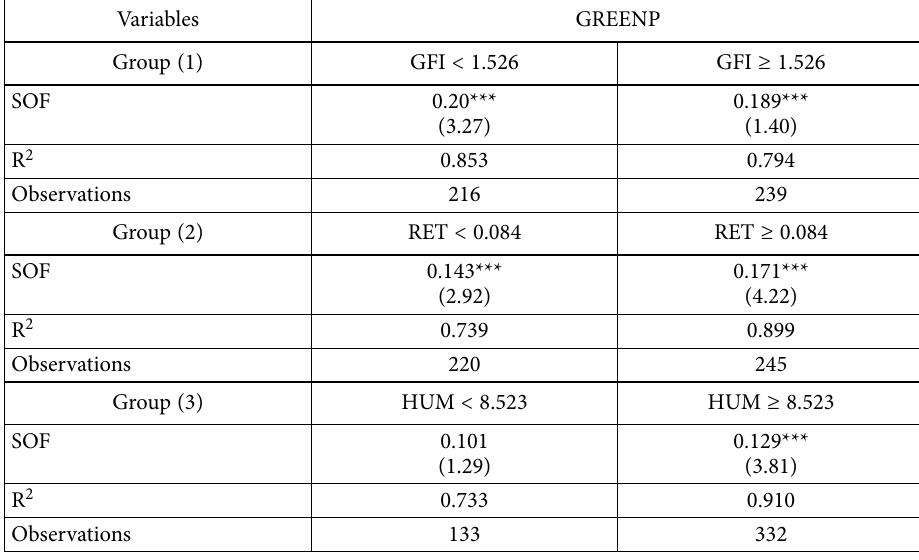
Table 8. Estimation for the threshold regression